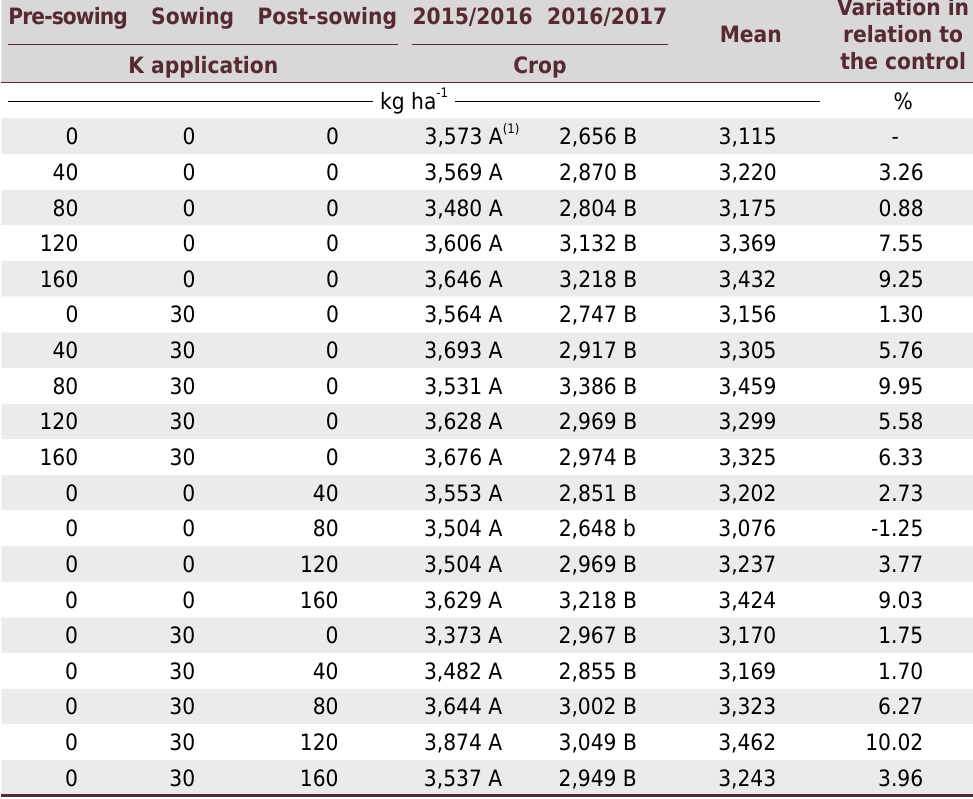
Table 5. Soybean yield in two consecutive growing seasons (2015/2016 and 2016/2017) Pre-sowing Sowing Post-sowing 2015/2016 2016/2017